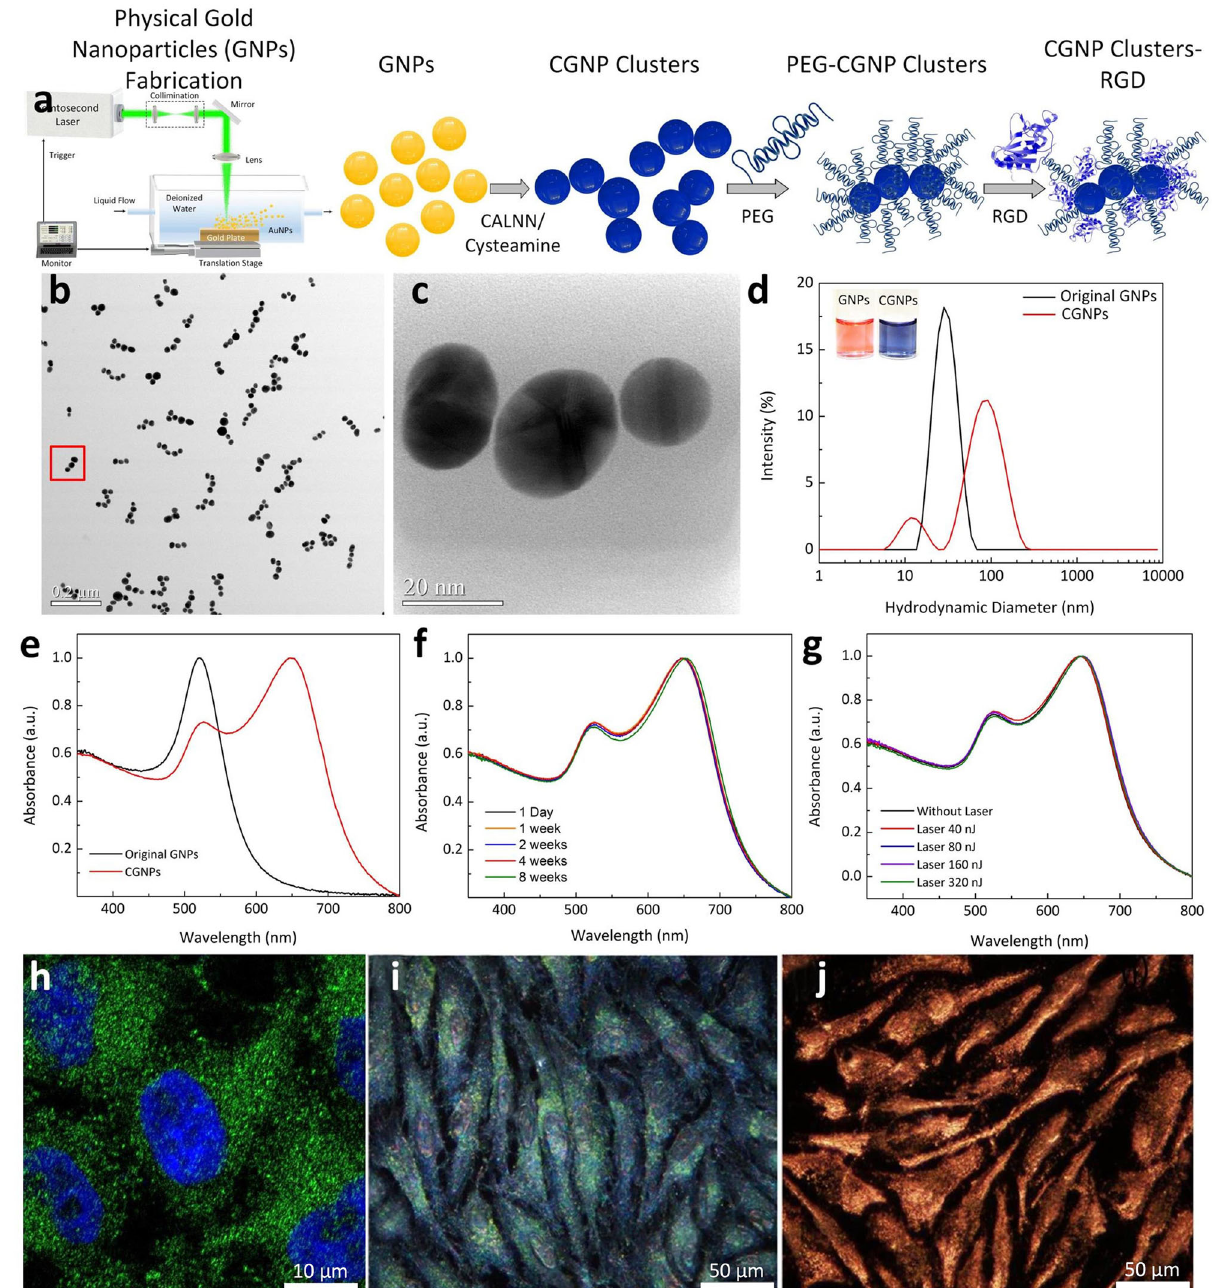
Fig. 1 Characterization of synthesized chain-like gold nanoparticle clusters conjugated with RGD peptide (CGNP clusters-RGD) and quanti fi cation of the photoacoustic (PA) and optical coherence tomography (OCT) properties. a Illustration of synthesis of CGNP clusters-RGD. Ultra-pure colloidal gold nanoparticles (GNPs) were fi rst fabricated by physical method (using femtosecond laser). Then, discrete GNPs were self-assembled using pentapeptide Cys-Ala-Leu-Asn-Asn (CALNN) and cysteamine in order to create CGNP clusters. b Transmission electron microscopy (TEM) image of CGNP clusters- RGD, ×2000, 20 kV; bar = 200 nm. c Region of CGNP clusters-RGD at high magni fi cation, indicated by red square box in b . The CGNPs surrounded with a gray shell representing CALNN-PEG-RGD layer. d Comparisons of hydrodynamic size between GNPs and CGNP clusters-RGD measured in water by using dynamic light scattering (DLS). e UV-Vis absorption spectra of GNPs and CGNP clusters-RGD. f Quantitative characterization of the colloidal stability of CGNP clusters-RGD over time for up to 8 weeks by using UV-Vis absorption spectroscopy analysis. g In vitro photostability of CGNP clusters-RGD during nanosecond pulsed laser irradiation (65 s) at various pulse fl uences (0.005, 0.01, 0.02, and 0.04 mJ/cm 2 ). h Confocal fl uorescent microscope image of single HeLa cell treated with FITC-labeled CGNP clusters-RGD at concentration of 50 µ g/mL for 24 h. Blue fl uorescent color indicates the cell ’ s nuclei stained with Hoechst 33342. Green color shows the position of CGNP clusters-RGD accumulated around the cell nuclei. i and j dark fi eld images of HeLa cells after incubated with conventional GNPs-RGD with diameter of 20 nm and CGNP clusters-RGD, respectively. Note that the internalized CGNP clusters-RGD appeared indicating that CGNP clusters-RGD were stable in biological tissue. Source data are provided as a Source Data fi le.